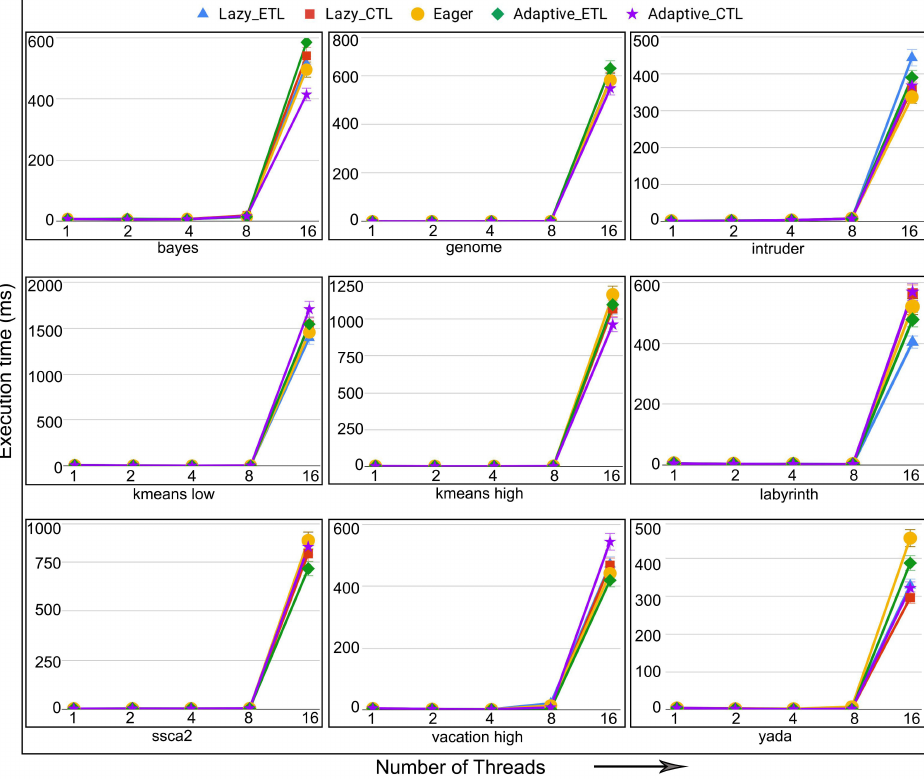
Figure 18. Execution time in STAMPEDE benchmarks executing in persistent